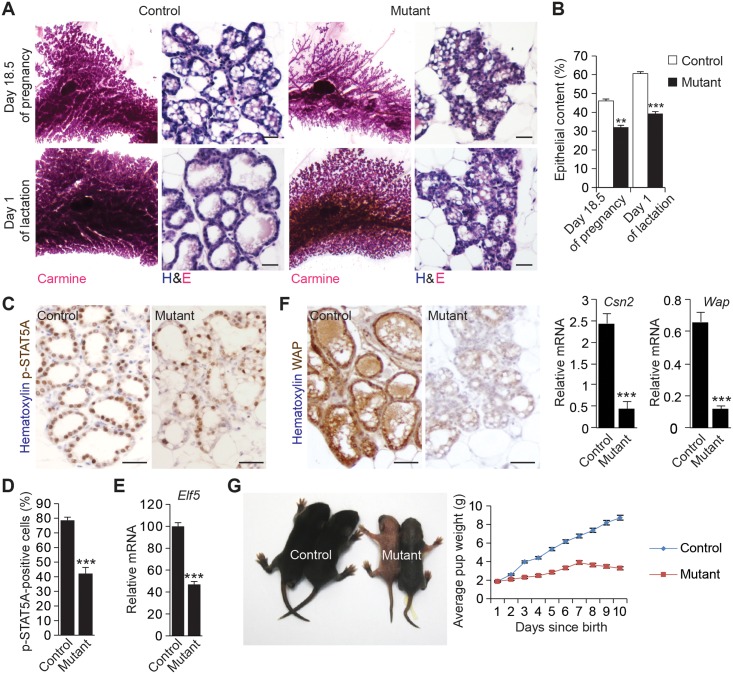
MMTV-driven loss of HTT affects alveolar morphogenesis.(A) Carmine-stained whole mounts of mammary glands and hematoxylin and eosin staining (H&E). Scale bars, 50 μm. (B) Quantification of the epithelial content (control: n = 6 mice; mutant: n = 6 mice). (C) Mammary gland sections stained for p-STAT5A. Scale bars, 10 μm. (D) Percentage of p-STAT5A-positive cells (control: n = 6 mice; mutant: n = 6 mice). (E) Quantitative real-time RT-PCR analysis of Elf5 gene expression. Data are presented as means obtained in three independent experiments (control: three mice per experiment, mutant: three mice per experiment). (F) Mammary gland sections stained for WAP. Scale bars, 10 μm. The histograms show quantitative real-time RT-PCR analysis of Csn2 and Wap gene expression. The values were normalized to Krt8 expression. Data are presented as means obtained in three independent experiments (control: three mice per experiment, mutant: three mice per experiment). (G) Average weight of pups. Data are presented as means obtained in two independent experiments (control: three mice per experiment, mutant: three mice per experiment). Error bars, SEM. ** p<0.01; *** p<0.001. Complete statistical analyses with number of measures are detailed in S1 Data.